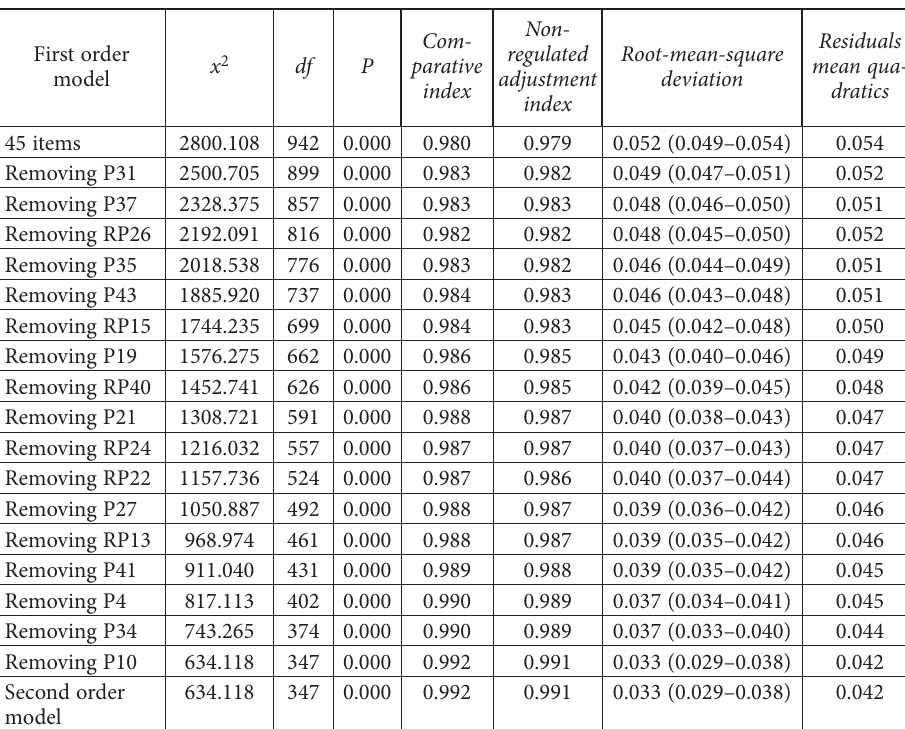
Table 2. Fit indices of the tested models (source: created by authors)